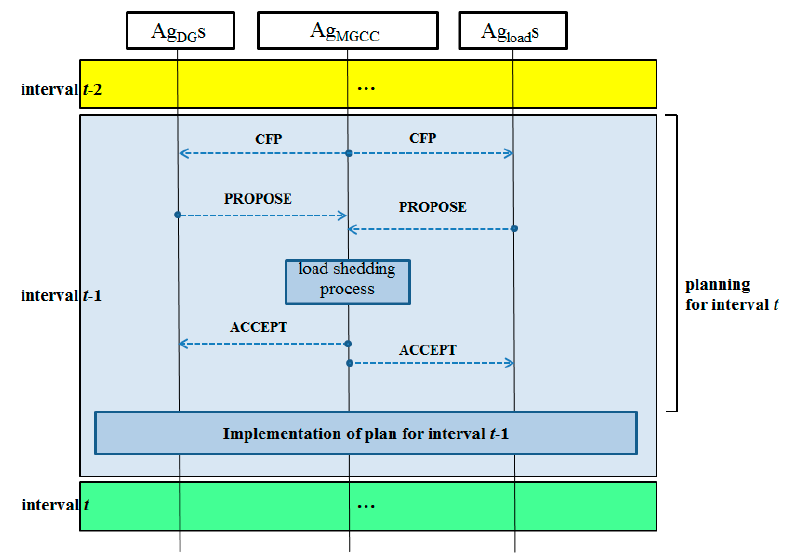
Energies 2017 , 10 , 45 7 of 13